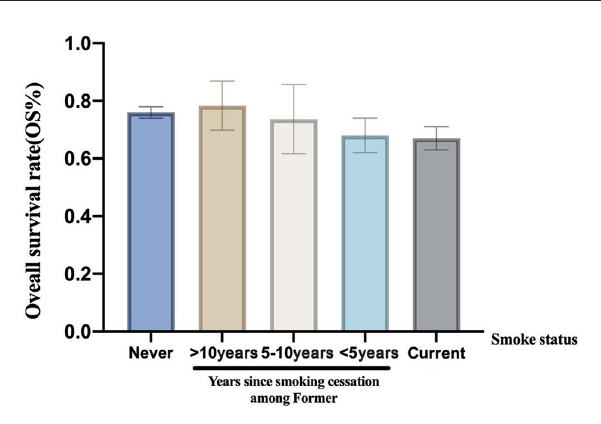
FIGURE4 The overall survival rate stratified according to smoke status and years since tobacco